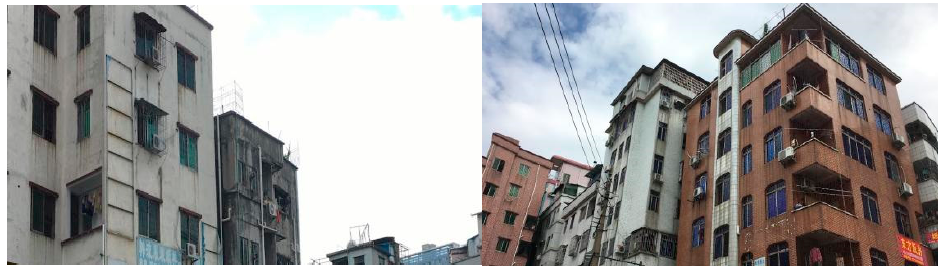
Figure 9. Villagers get income from house rentals in Guangzhou. Source: taken by the authors.